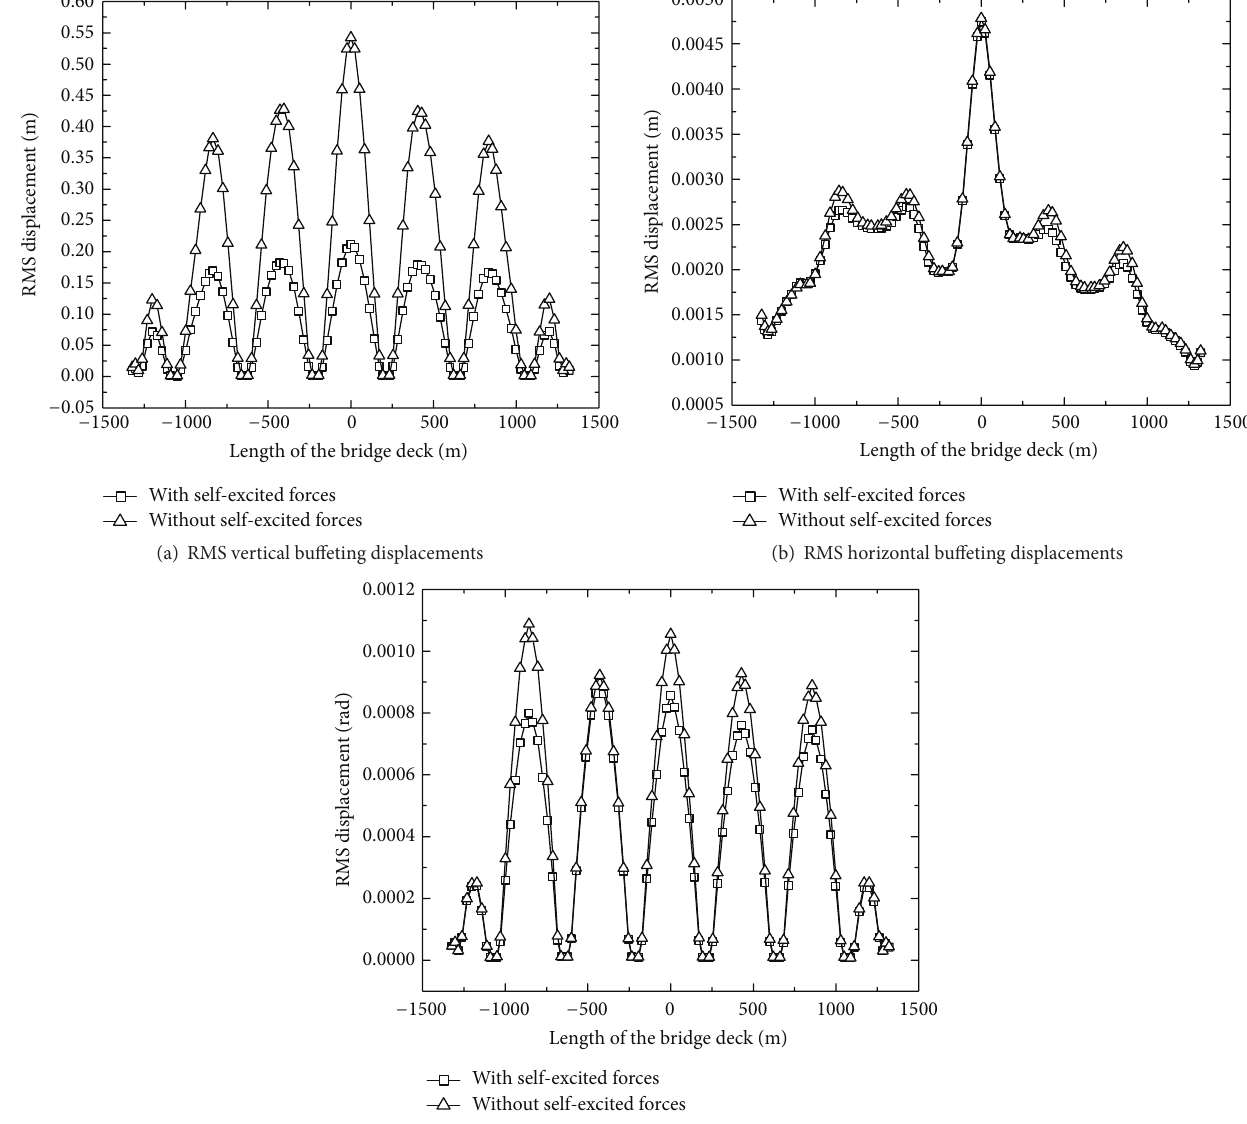
Figure 15: Comparisons of RMS buffeting responses of bridge